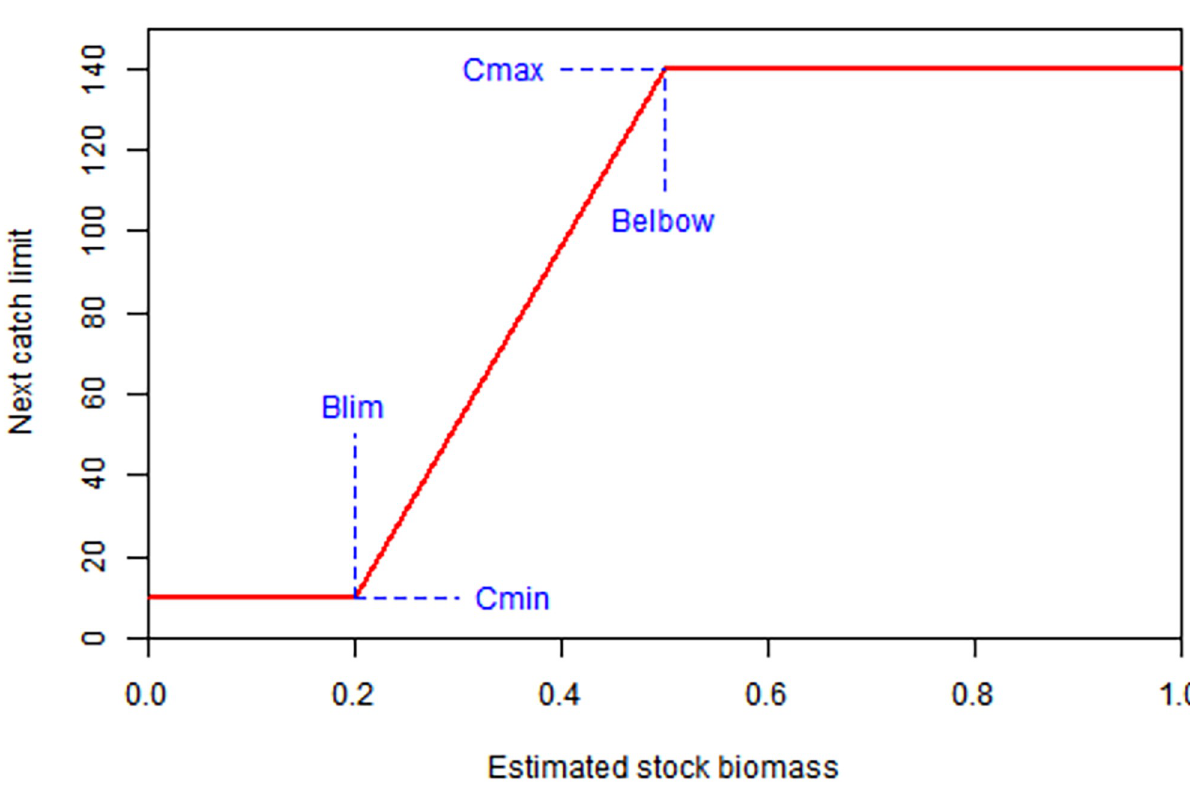
Fig 1. The shape of the HCR. The shape of the HCR is determined by four parameters: Cmax , Cmin , Blim and Belbow that provide the coordinates for the two inflexion points. In the example shown, Cmax = 140, Cmin = 10, Blim = 0.2 and Belbow = 0.5. Users can change each parameter to alter the shape of the HCR. The catch limit in the next year is based on the estimated stock biomass in the current year.